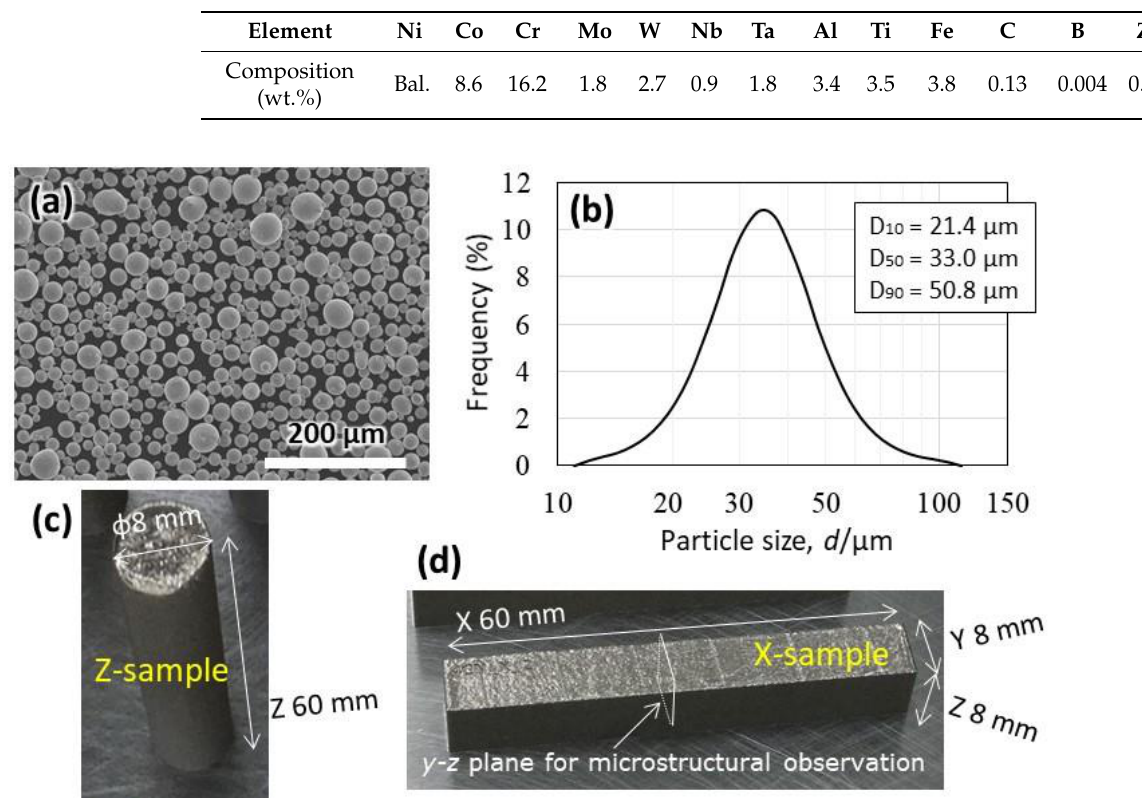
Figure 1. ( a ) SEM image and ( b ) particle size distribution of IN738LC powder, and pictures of ( c ) Z-sample and ( d ) X-sample along the z -direction and the x -direction, respectively.